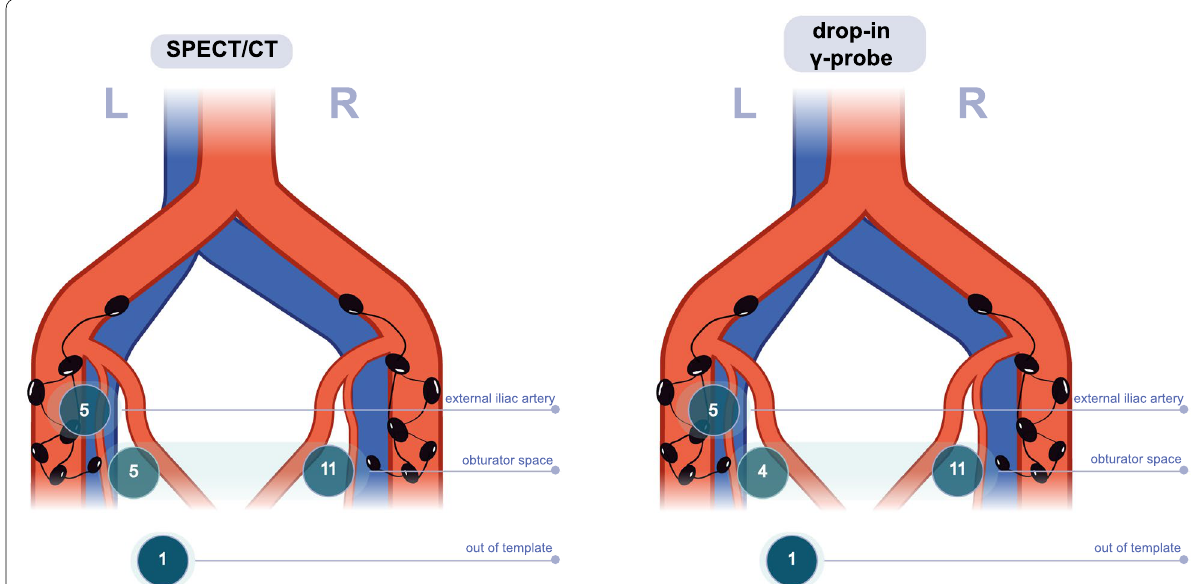
Fig. 2 Sentinel lymph node localization with preoperative SPECT/CT (left) and intraoperative drop-in γ-probe (right). The out of template node detected with SPECT/CT only was located near the aortal bifurcation (and not detected with the drop-in γ-probe). The out of template node detected intraoperatively with drop-in probe was located in the deep obturator space (on SPECT/CT assessed as located within the obturator